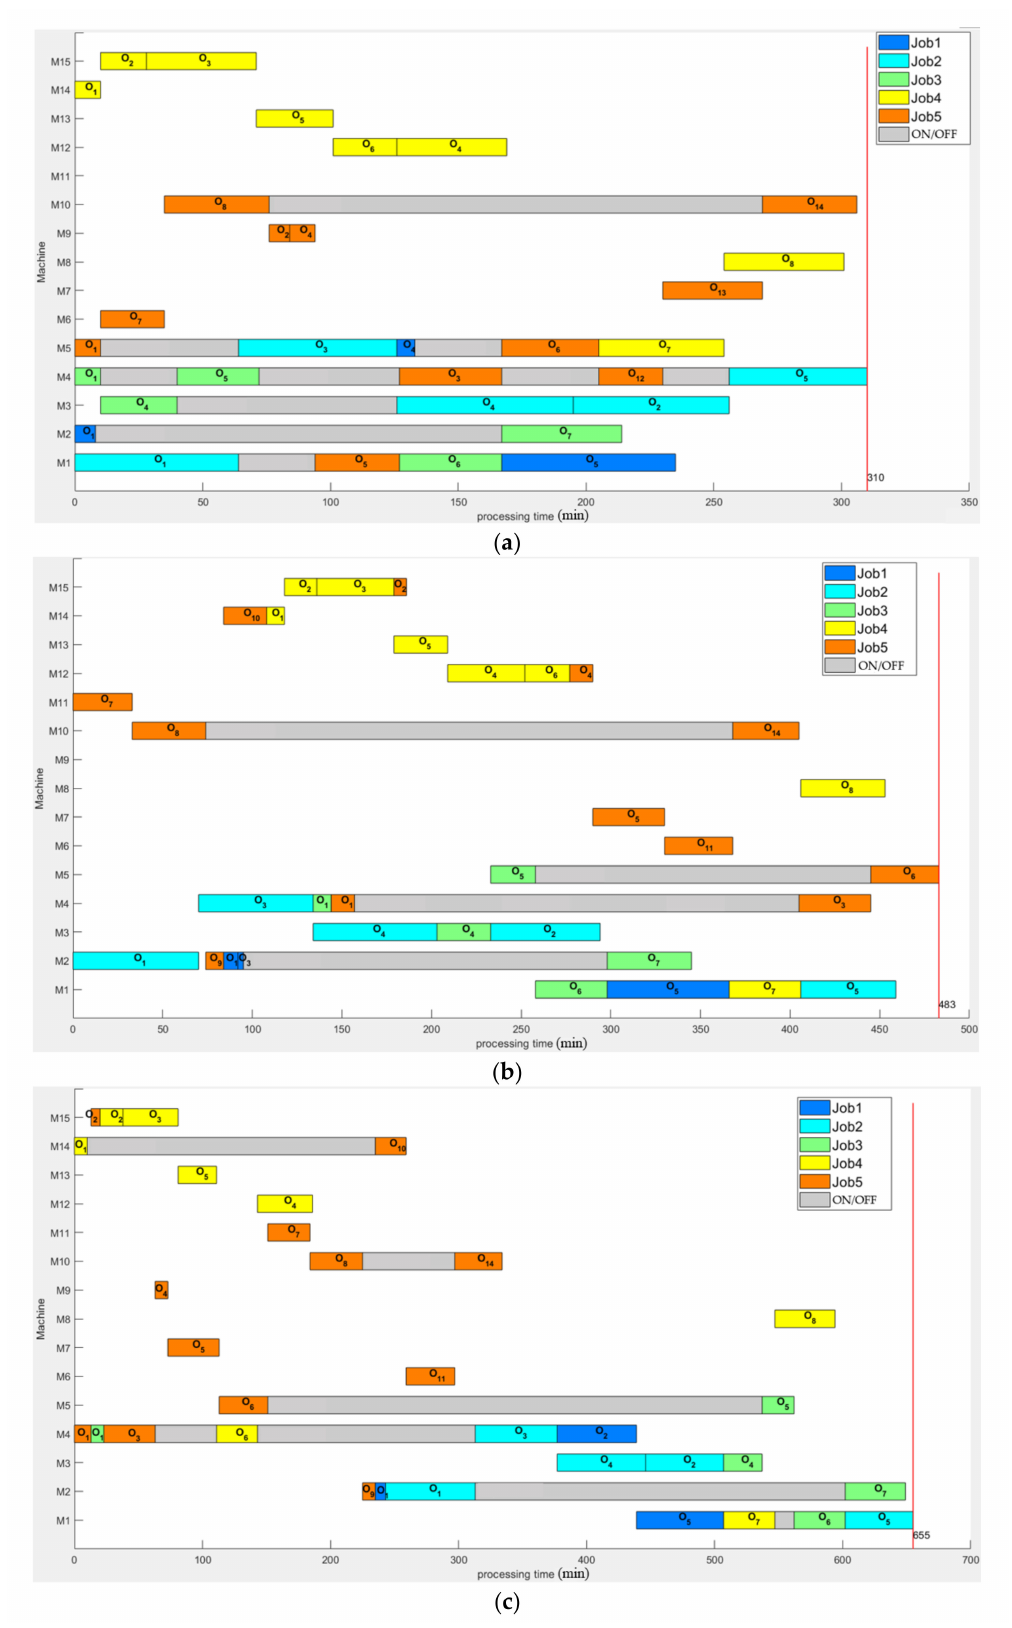
Figure 11. The Gantt charts of the optimal scheduling schemes: ( a ) when C max is optimal; ( b ) when E Total is optimal; ( c ) when P Total is